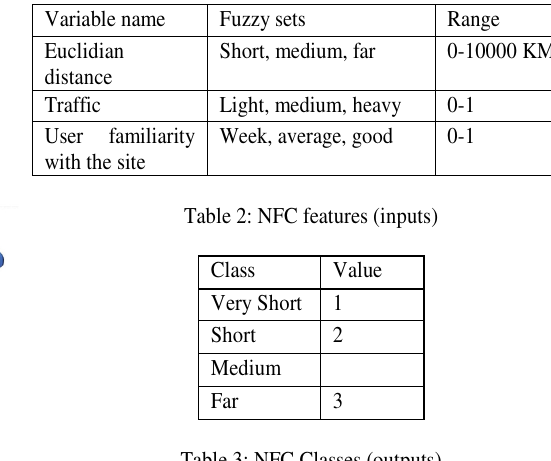
Figure 5. OTDR Trace Information (Thefoa.org, 2014)